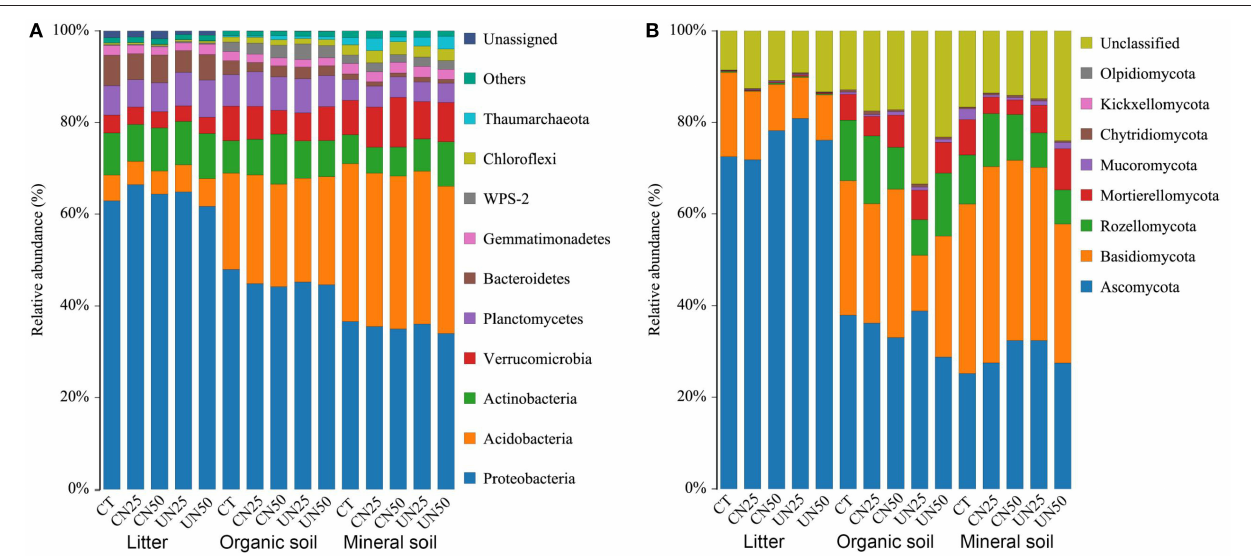
FIGURE 1 | Relative abundance of the dominant bacterial groups (A) and fungal groups (B) at the phylum level under different N addition treatments and different soil layers. CT, control without N addition; CN25, canopy N addition with 25kg N ha − 1 year − 1 ; CN50, canopy N addition with 50kg N ha − 1 year − 1 ; UN25, understory N addition with 25kg N ha − 1 year − 1 ; UN50, understory N addition with 50kg N ha − 1 year − 1